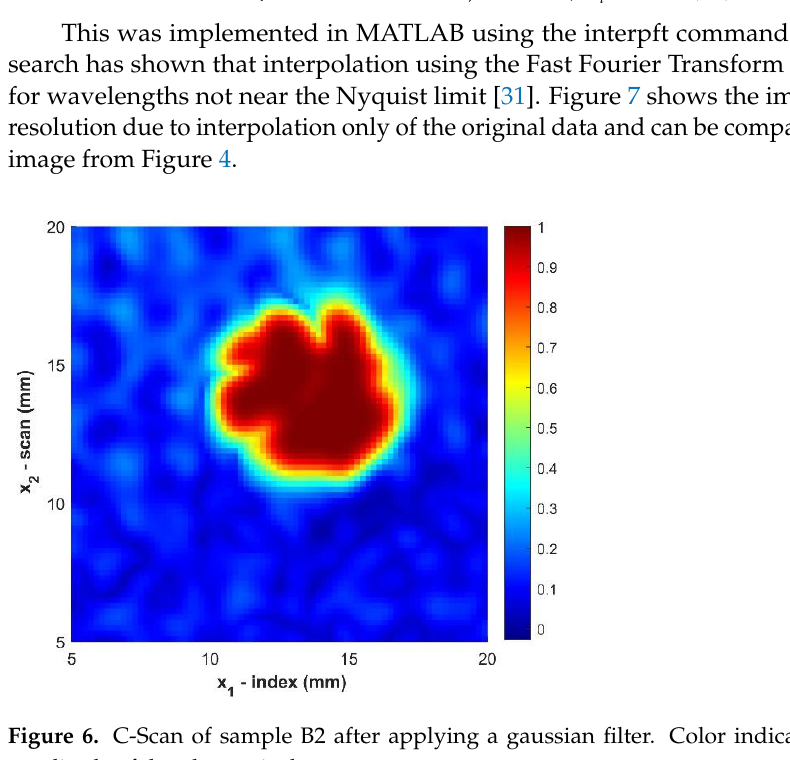
Figure 6. C-Scan of sample B2 after applying a gaussian filter. Color indicates the normalized amplitude of the ultrasonic data.